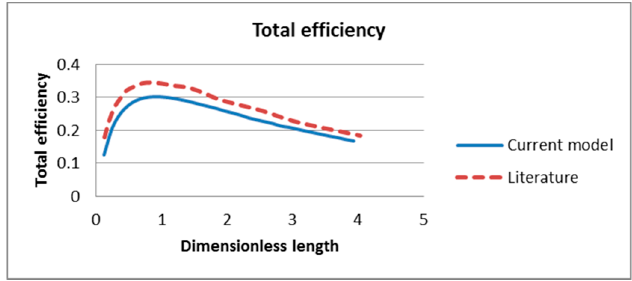
Figure 8. Comparison of total efficiency of current model and literature model [29].